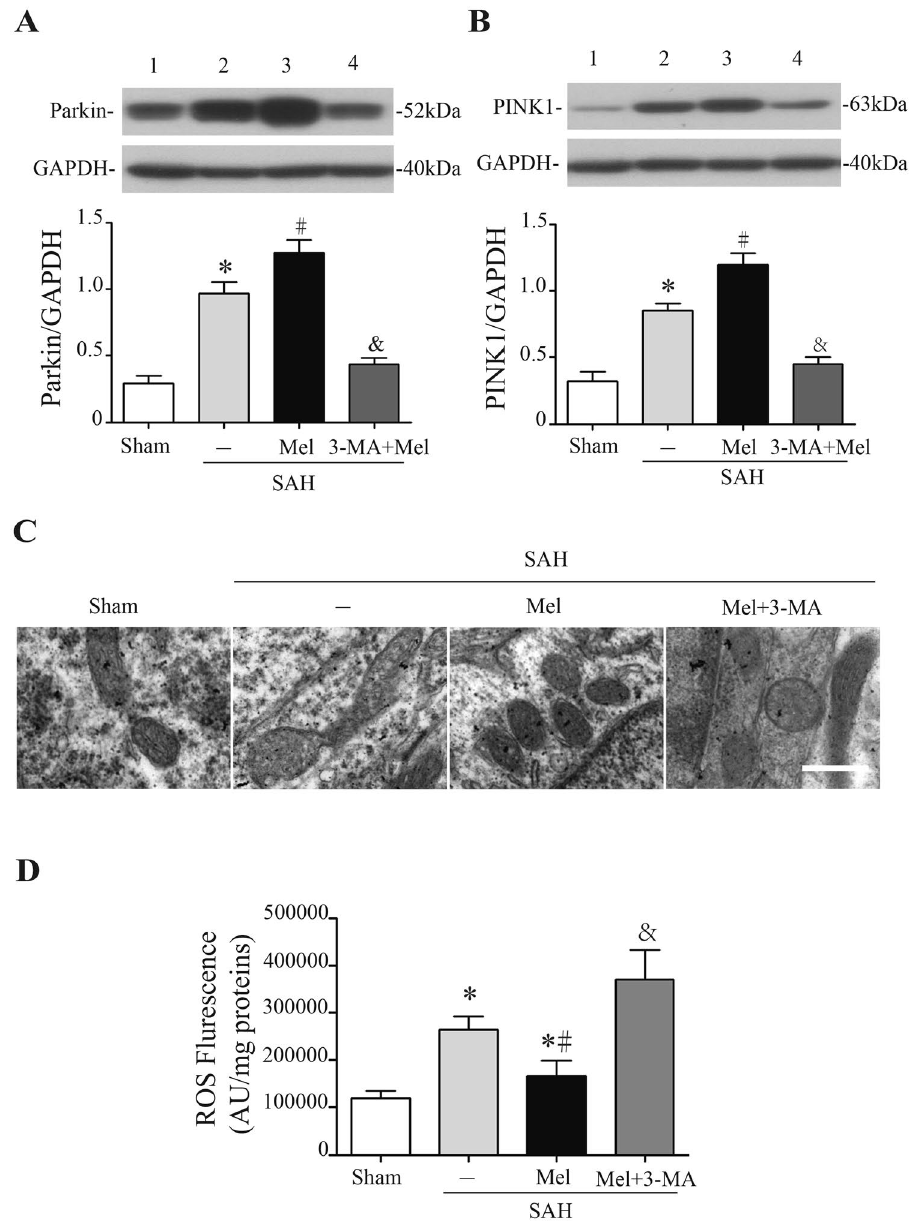
Figure 3. Effect of melatonin treatment on mitophagy and ROS generation. ( A ) The Western blot relative band density of Parkin; n = 6 per group. ( B ) The Western blot relative band density of PINK1; n = 6 per group. The cropped bands had been run under the same experimental conditions. ( C ) Ultrastructural changes in mitochondria in the ipsilateral basal cortex at 24 h after SAH induction. ( D ) The quantification of ROS levels in the ipsilateral basal cortex at 24 h after SAH; n = 6 per group. * P < 0.05 versus sham group, # P < 0.05 versus SAH + vehicle group, and & P < 0.05 versus SAH + Mel